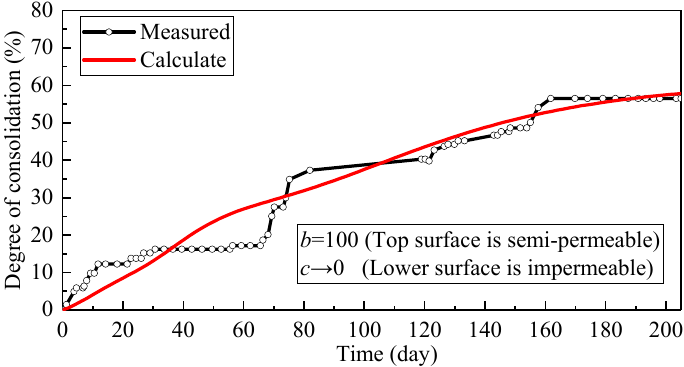
Figure 9. Comparison of measured and calculated values of settlement.